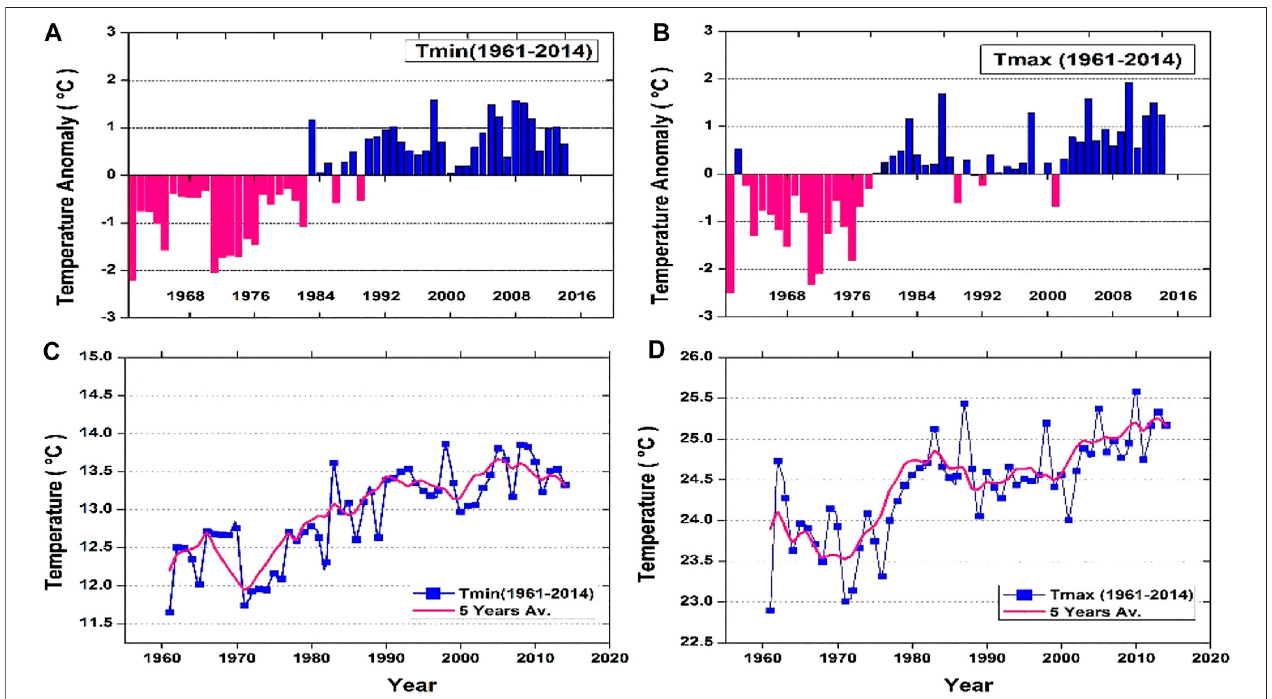
FIGURE 8 | Standardized anomalies of (A) minimum temperature, (B) maximum temperature and (C) minimum temperature trend, (D) maximum temperature trend over Rwanda for the period of 1961 – 2014. The pink line represents the 5-years running.